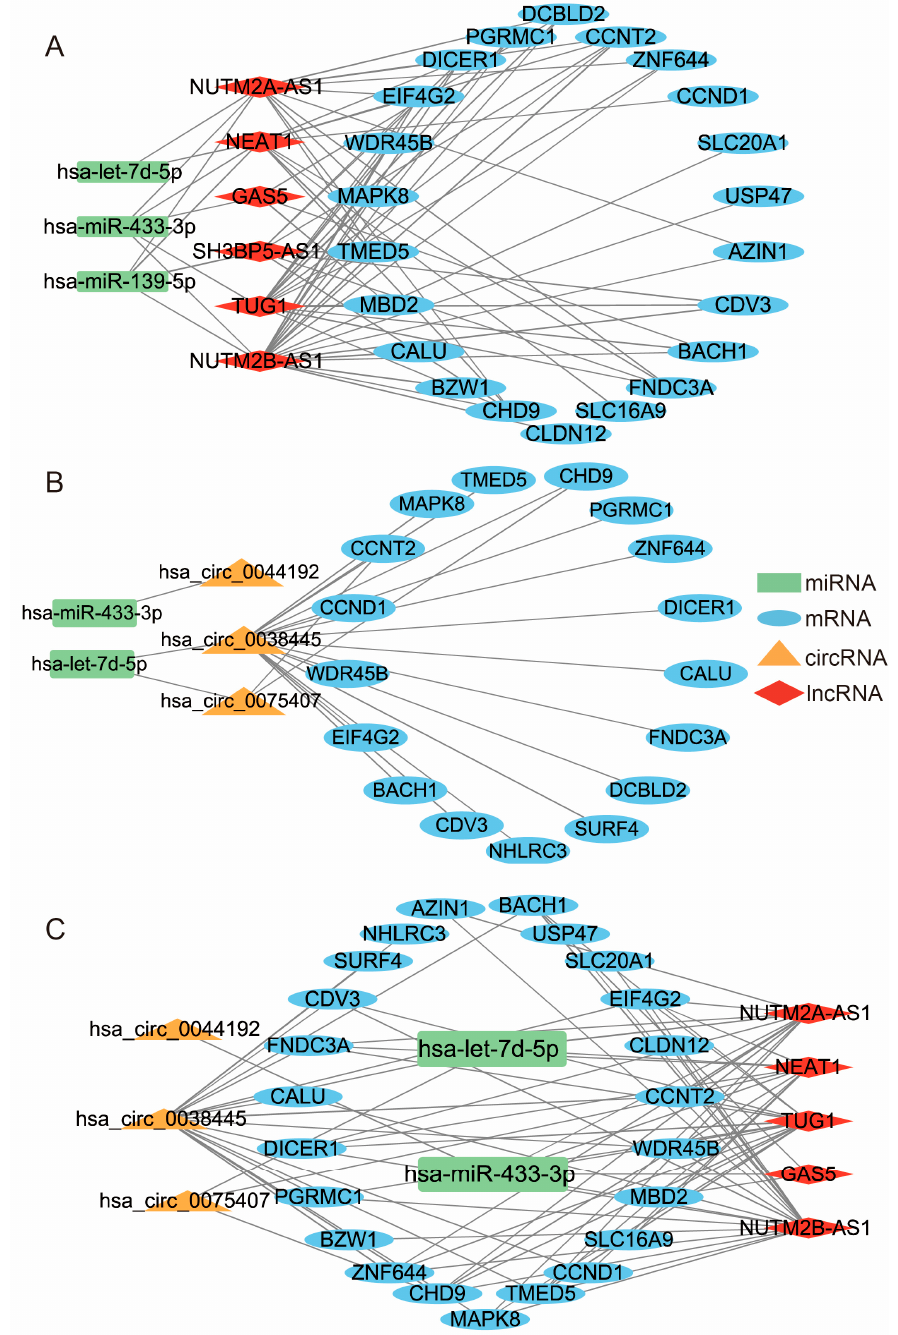
Figure 5. ( A ) The lncRNA – miRNA – mRNA network. ( B ) The circRNA – miRNA – mRNA network. ( C ) The ceRNA network. ( C ) The ceRNA